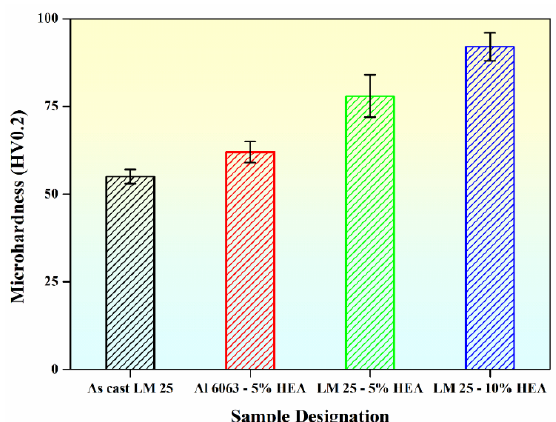
Figure 8. The microhardness values of the Al-based composites as a function of different HEA con- tent.